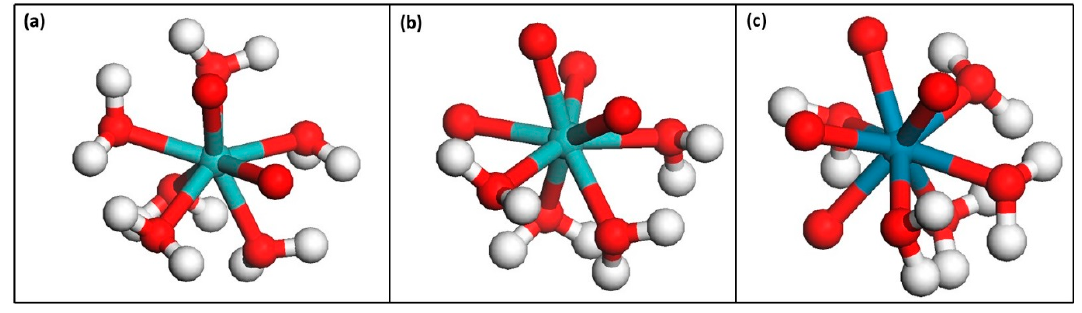
2+ MoO , ( b ) 2 MoO − , and ( c ) ReO − . − − , ( b ) MoO 2 , and ( c ) ReO . 2 4 4 4 4 2